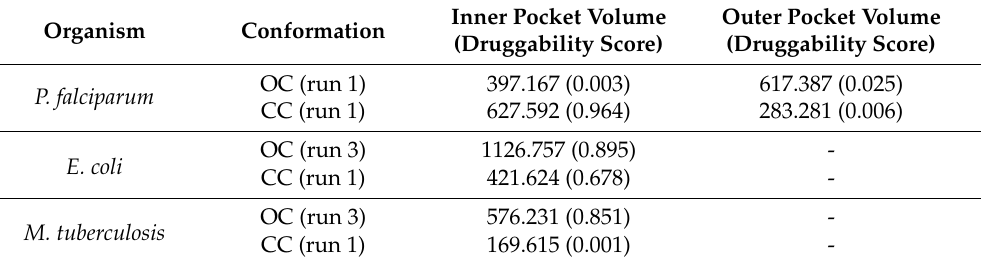
Table 1. Pocket analysis of the representative structures of both the open and closed conformations of